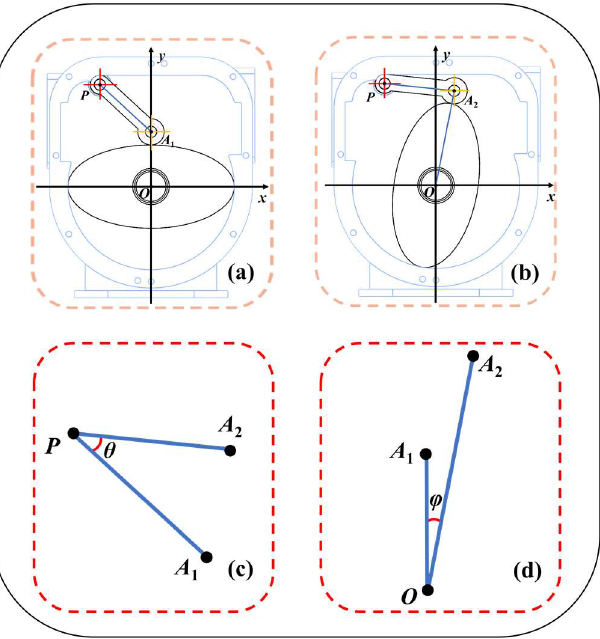
Figure 5. Auxiliary diagram for mathematical modeling. ( a ) The initial state of the ERSP, ( b ) rotation limit of the ERSP, ( c ) scraper rotation angle, ( d ) rotor rotation angle. Figure 5c is the coplanar graph of PA 1 and PA 2 in the same coordinate system, and